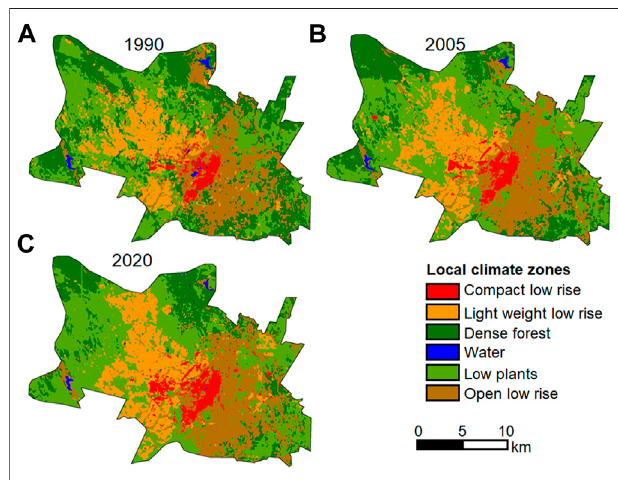
FIGURE 1 | Long-term changes in LCZs in Bulawayo. LCZ structure in 1990 (A) , 2005 (B) and 2020 (C)